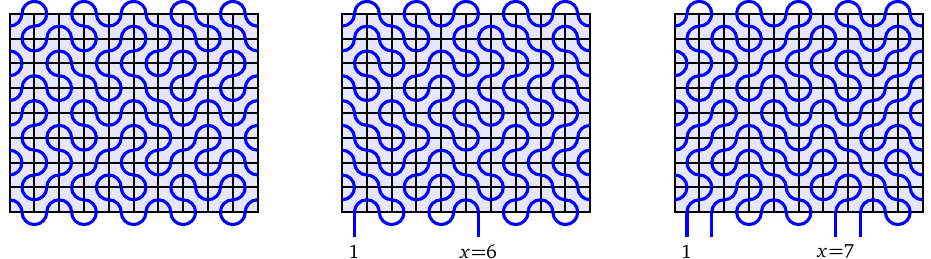
Figure 1: Loop configurations on the 10 (cid:2) 8 cylinder, with the boundary conditions correspond- ing to Z , Z ( x = 6 ) and Z ( x = 7 ) 0